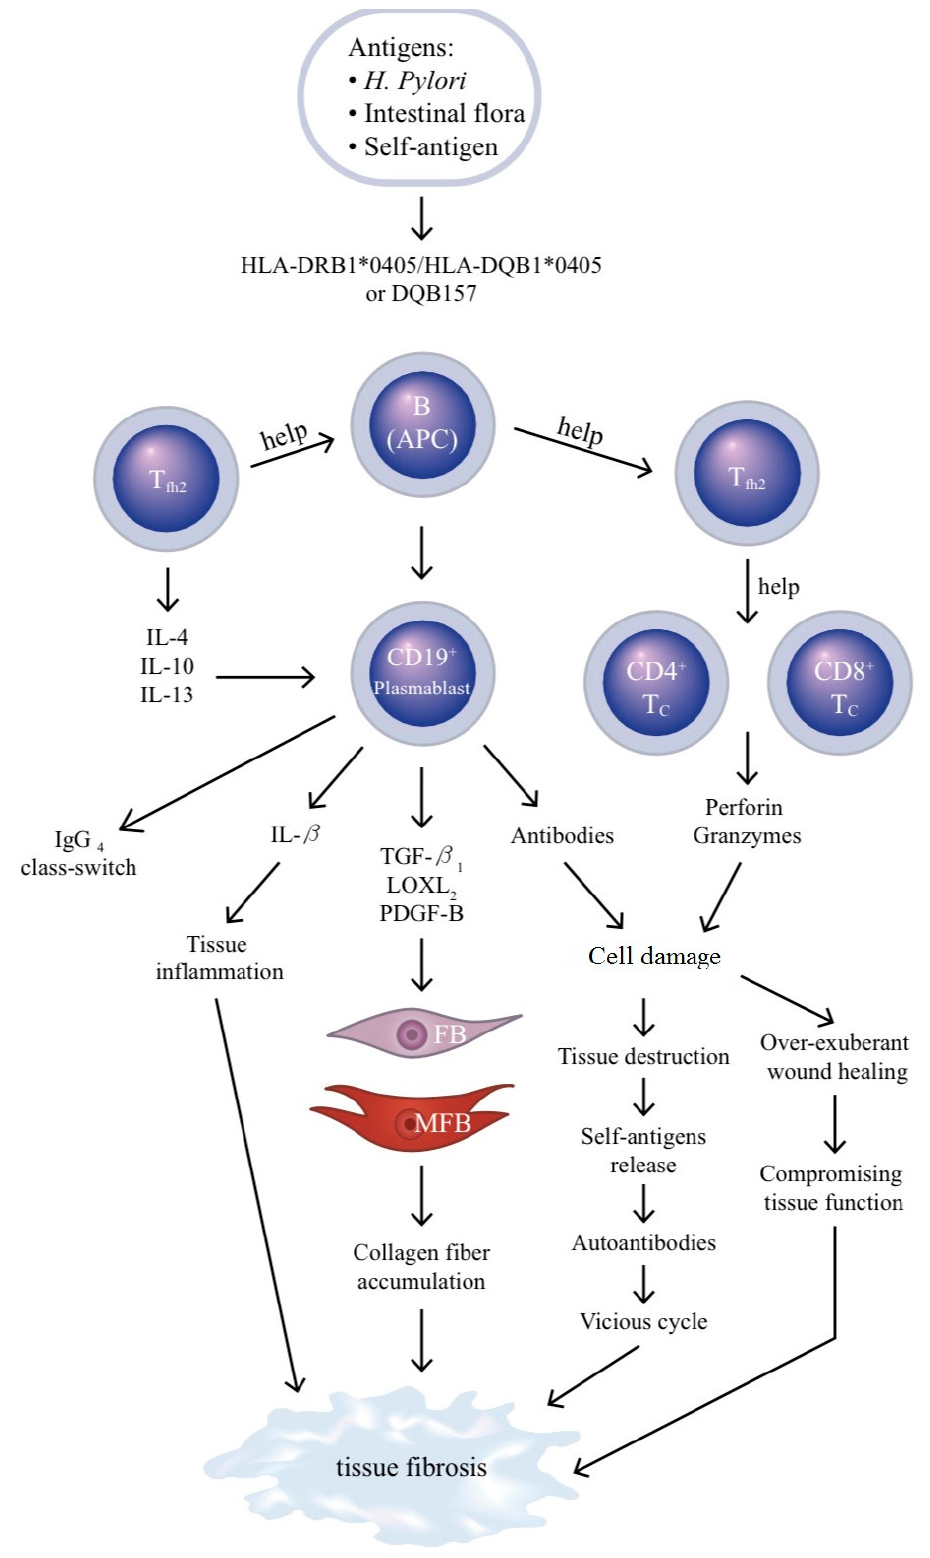
Figure 1. Pathogenic role of the B lymphocyte as antigen-presenting cell (APC) and e ff ector cell in the tissue fibrosis of patients with IgG4-related disease. The genetically predisposed B cells (acting as APCs) bind to environmental o ff ending agents (e.g., H. pylori ), intestinal microflora or autoantigens and then provide signals to CD19 + plasmablasts to mediate e ff ector functions including: (1) IgG4 class-